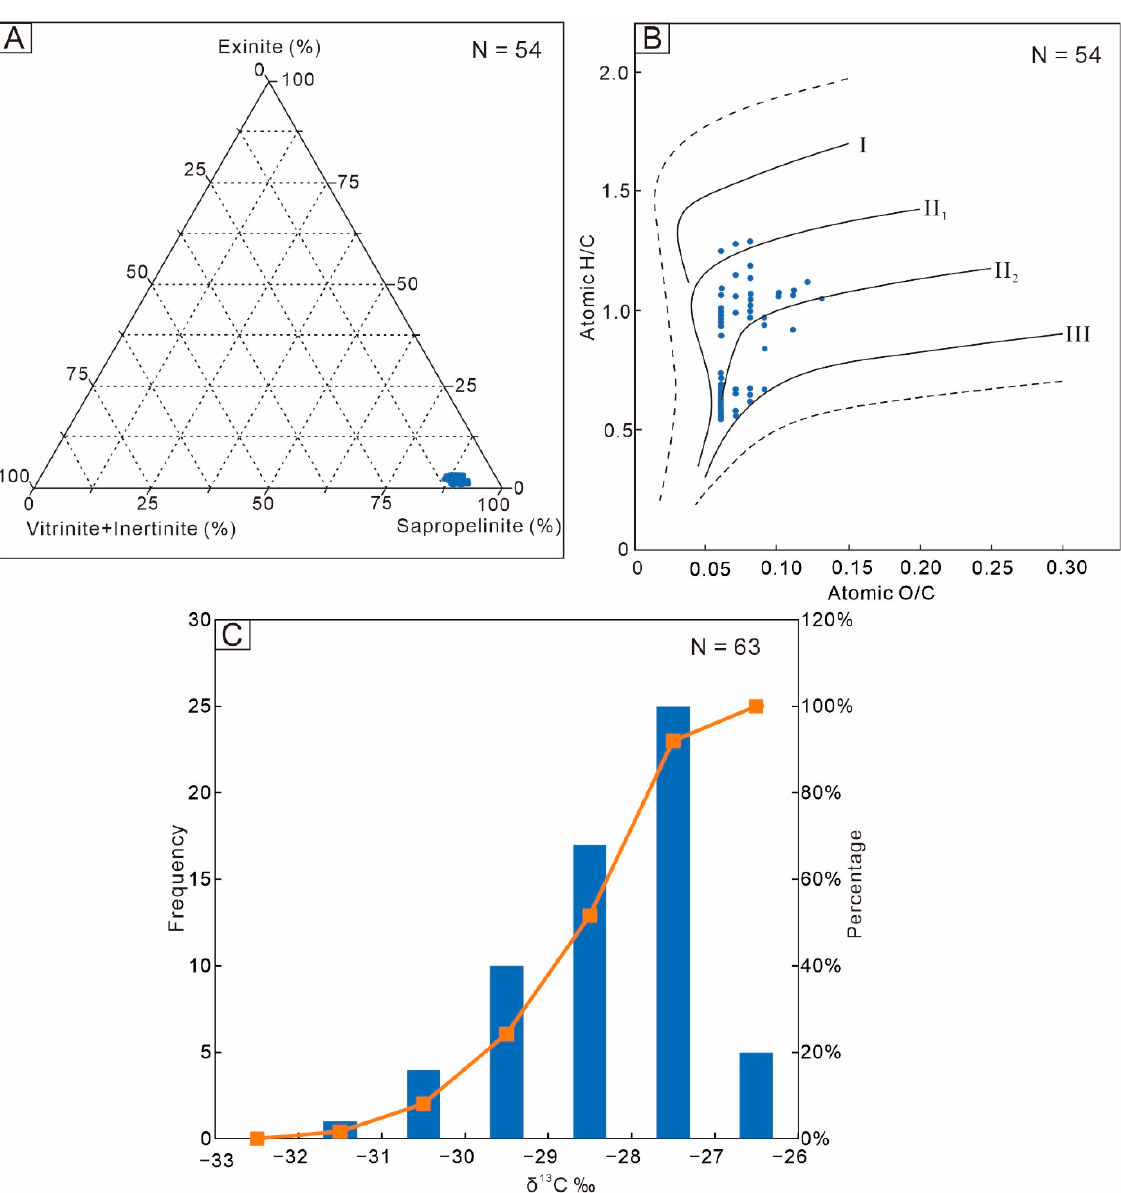
Figure 8. ( A ) Triangle figure showing the maceral compositions of FGSRs. ( B ) Classification of ker ‐ ogen types of the FGSRs according to the van Krevelen diagram [71]. ( C ) Histogram of the δ 13 C values.